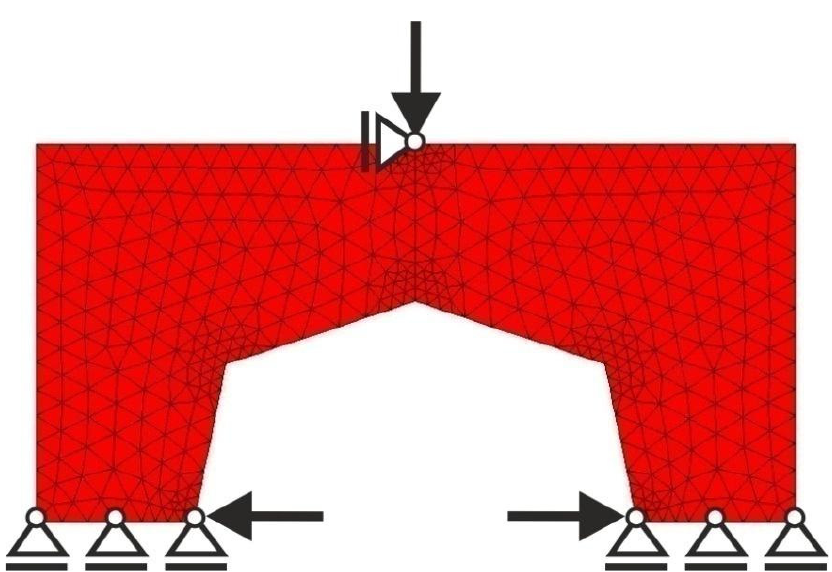
Figure 24. The portal frame: dimensions in mm.